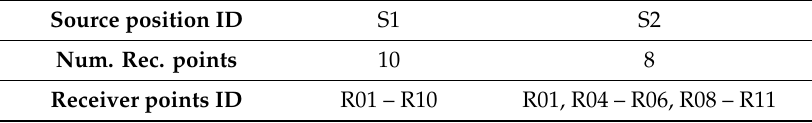
Table 2. Summary of the source-receiver combinations included in the survey. Source position ID S1 S2 Num. Rec. points